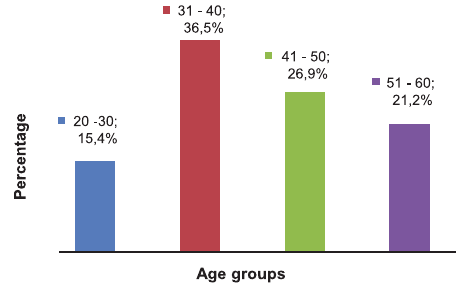
FIGURE 1. Sample structure by age groups